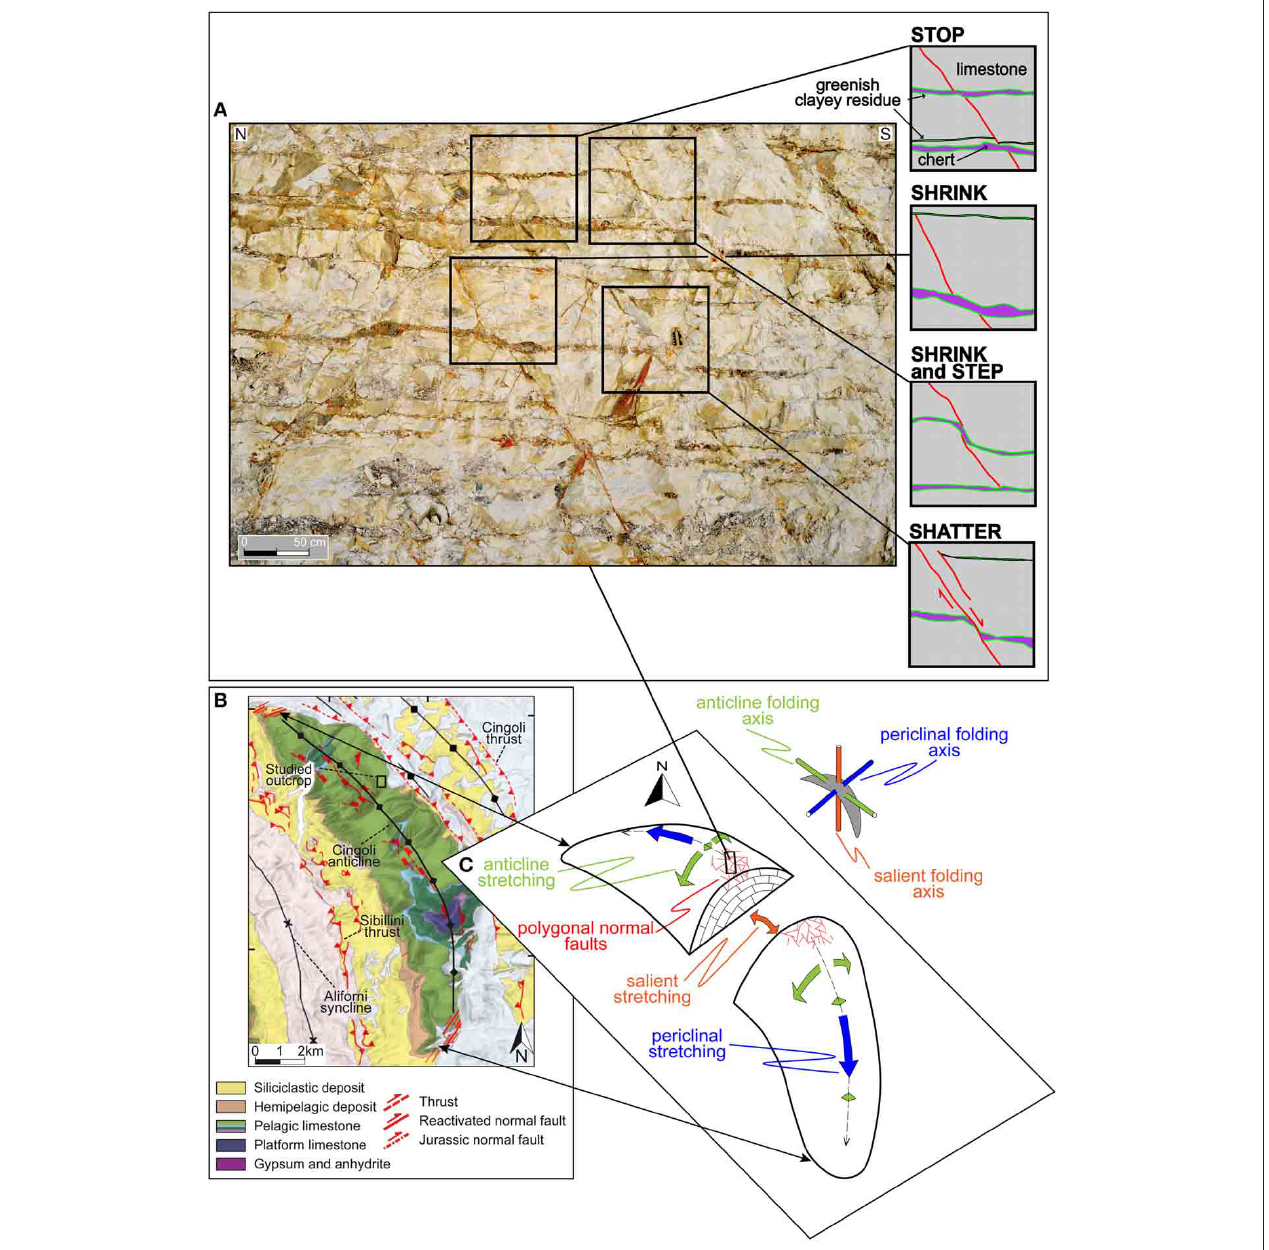
FIGURE 15 | (A) Final synthetic photograph and fault growth model. This photograph, where the steps of fault growth shown in the model of Figure 14 are all present within an outcrop area of about 15 m 2 , represents a snapshot of nascent polygonal faults in close proximity within carbonate beds. In this setting, the chert layers acted both as opponents to the fault propagation and as indirect promoters of new fault nucleation in the carbonates to accommodate the ongoing stretching strain at the extrados of the developing Cingoli anticline. This snapshot is contextualized within (B) the geological map of the Cingoli anticline (same as Figure 2B ) and (C) a three-dimensional model of the triply-folded anticline. In the anticline hinge and crestal region, note the three stretching axes normal to the three folding axes (anticline, periclinal, and